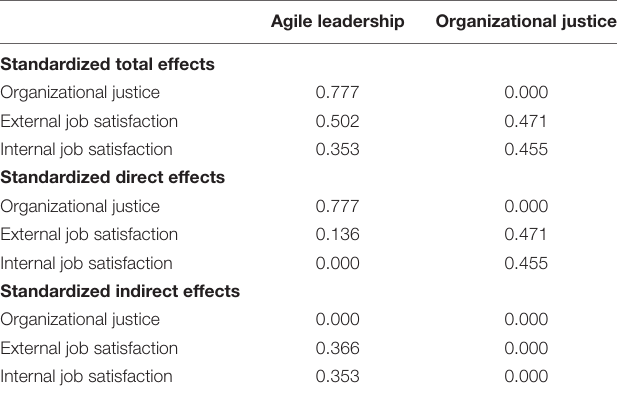
TABLE 5 | Standardized total, direct and indirect effect values between